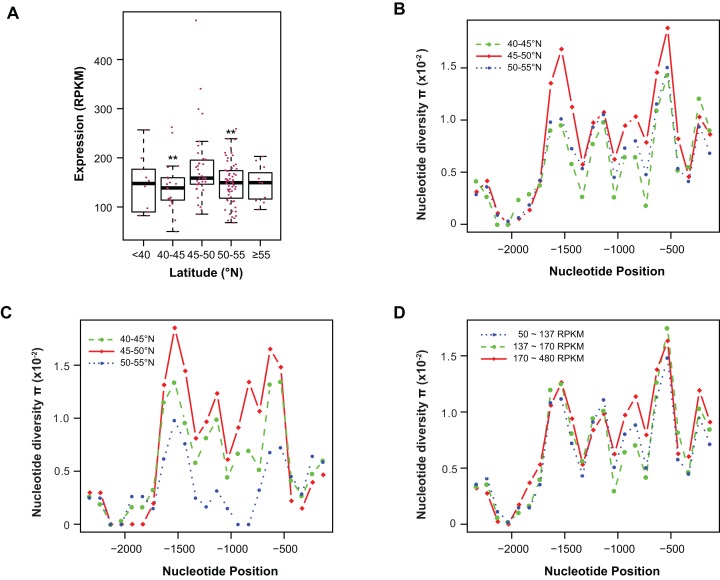
Contribution of sequence polymorphism to gene expression.(A) Latitudinal variation of ASK1 expression. Asterisks indicate that the mean expression of the indicated group is significantly lower than that of the group within latitudes 45–50°N (Wilcoxon rank-sum test, p < 0.01). (B) A window-slide polymorphic comparison of a 2.5 kb region upstream of the transcriptional start site of ASK1 among populations from three latitudinal regions as in (A). (C) A window-slide polymorphic comparison of a group of test populations from three latitudinal regions, performed as in (B). (D) A window-slide polymorphic comparison of three groups of populations with low, medium, and high expression levels of ASK1 that was performed as in (B).